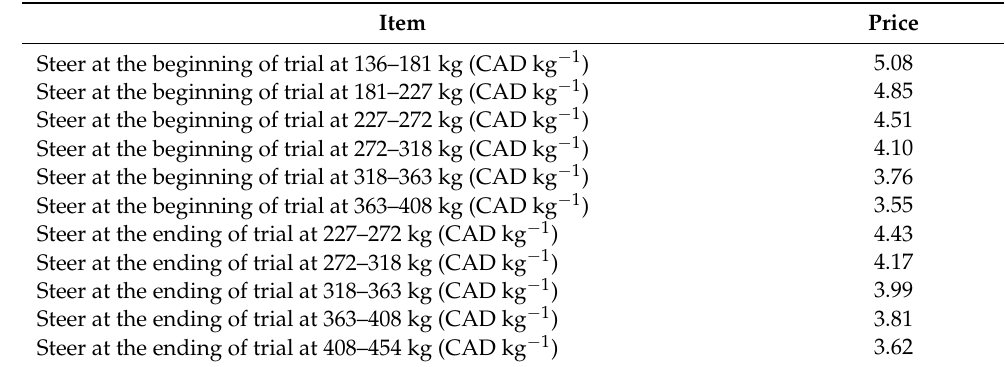
Table 2. Input and output prices. The average steer prices at beginning and end of trial were based on the Alberta Weekly Feeder Prices from 2010 to 2018 in